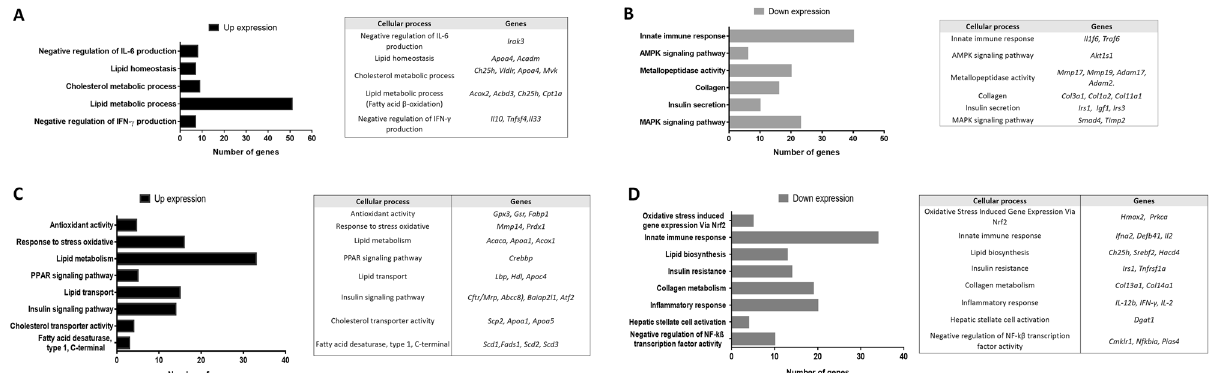
Figure 4. Microarray analysis of cellular pathways with gene dysregulation. CVD compared to HFD: ( A ) pathways with upregulated genes and ( B ) cellular tracks with decreased gene expression. PFD compared to HFD: ( C ) shows cell processes with gene overexpression and ( D ) metabolic pathways with decreased gene expression. CVD conventional diet, HFD high fat and high carbohydrate diet, PFD high fat and high carbohydrate diet + prolonged-release